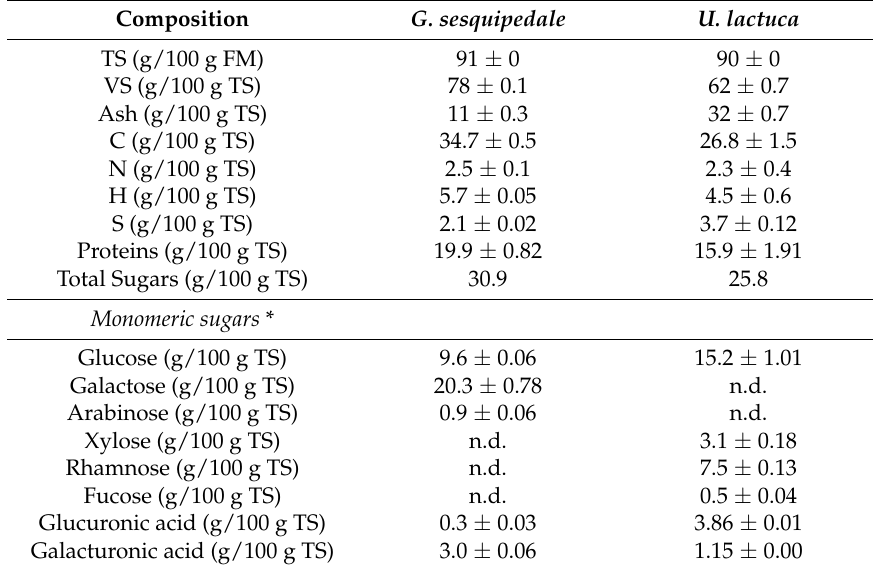
Table 1. Chemical composition of red G. sesquipedale and green U. lactuca Values correspond to mean ± SD (standard deviation) of measurement performed in